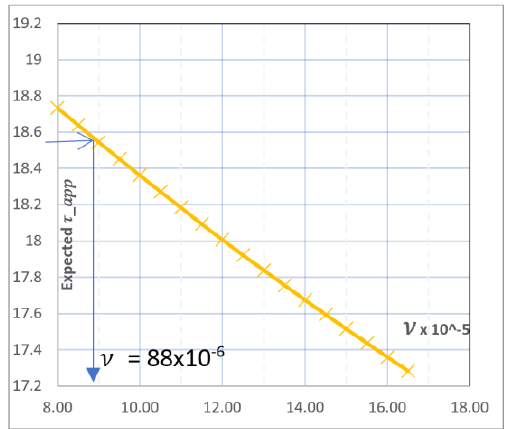
Figure 5. 𝜏 𝑎𝑝𝑝 versus ν for the first group of data points (6.5 mm < h < 7.5 mm). Figure 5. τ app versus ν for the first group of data points (6.5 mm < h < 7.5 mm). Equation (6) suggests that the size of BC members would influence their shear